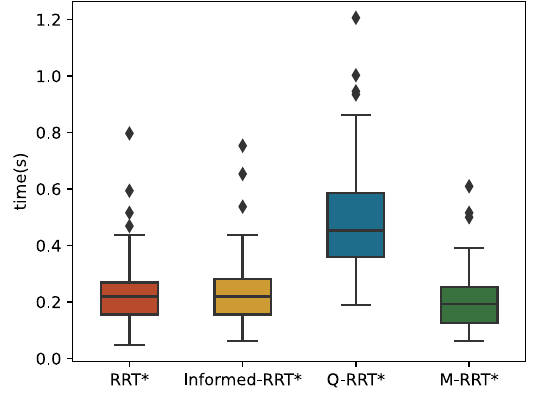
Figure 16. t init in the Maze.